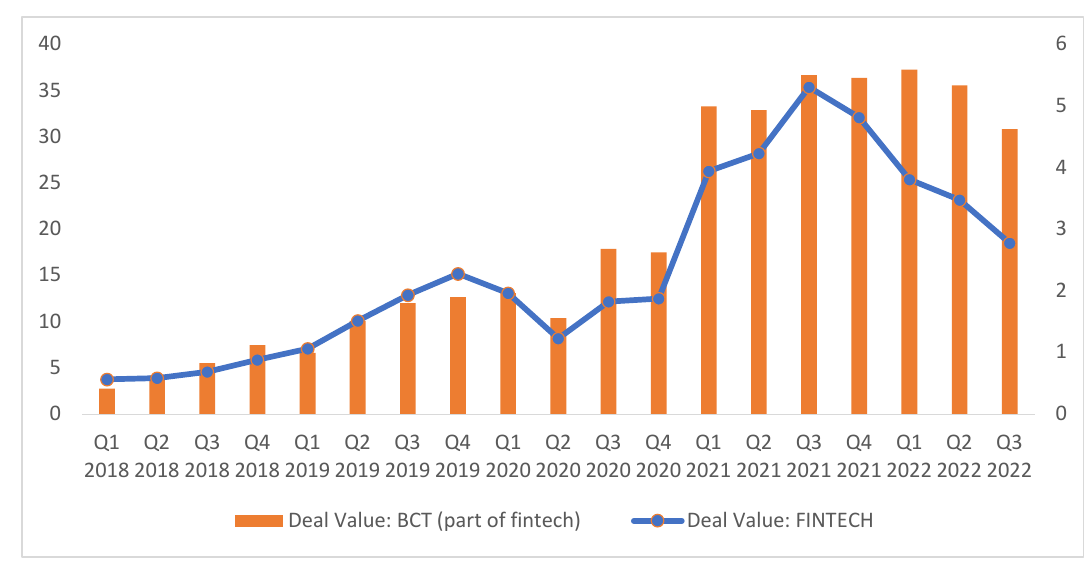
Figure 4. VCF activity in fintech and BCT: 2018–2022. Source: authors’ analysis.